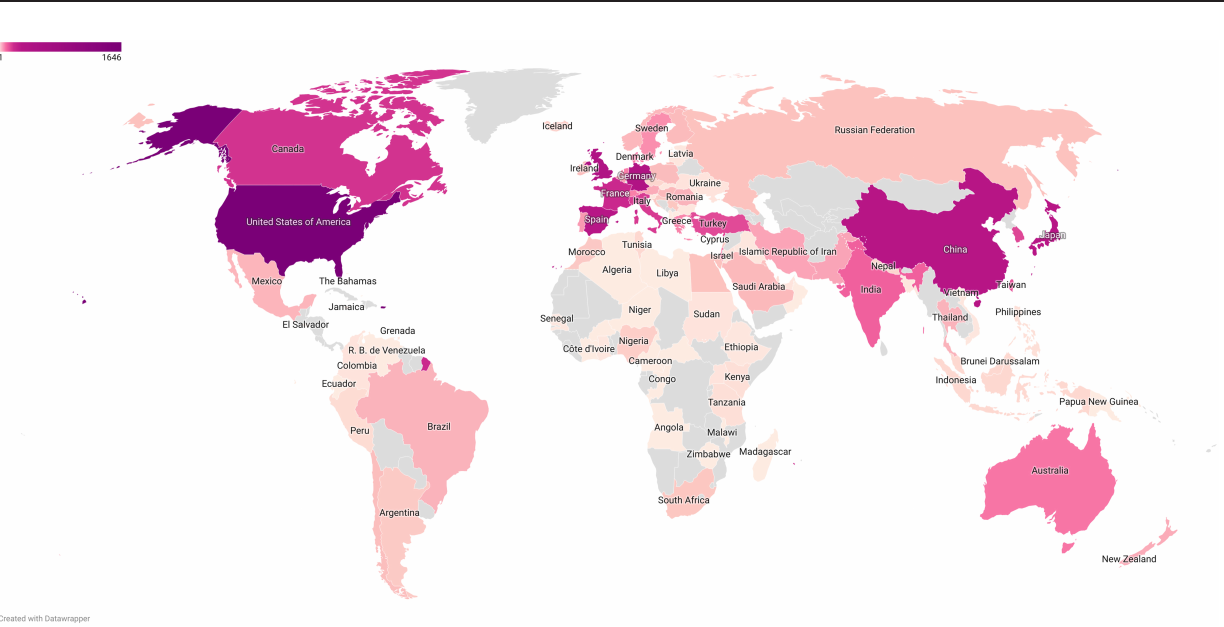
Figure 2. World map for the distribution of articles by country on gastrointestinal bleeding. In the indicator given at the top left of the figure, productivity increases from light to